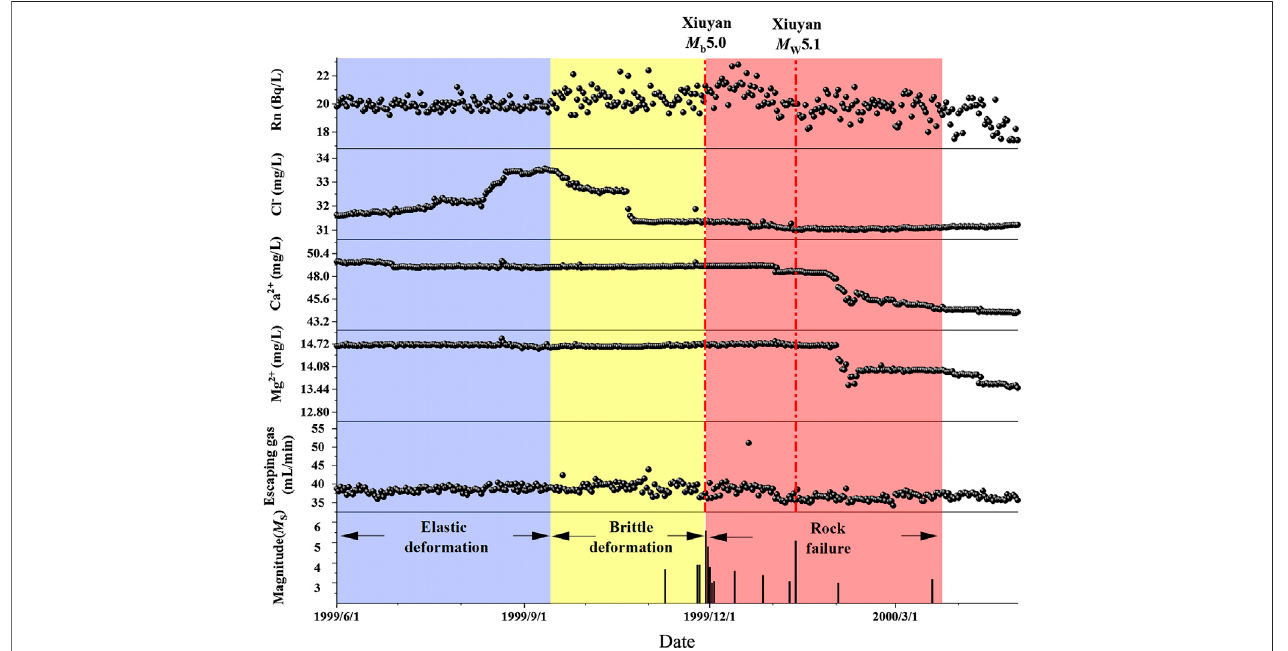
FIGURE4| Timeseriesofwaterradon,Cl − ,Ca 2+ ,andMg 2+ concentrationsandescapinggas fl owatthePanjinobservationwellandtheirrelationshipstothe1999 Xiuyan M b 5.0 and 2000 M W 5.1 earthquakes (shown by red dashed lines). The bottom panel shows M S ≥ 3 foreshock and aftershock of Xiuyan earthquakes (http:// www.csi.ac.cn/). Blue shading shows the elastic deformation stage; yellow shading shows the brittle deformation stage; and red shading shows the rock failure stage.